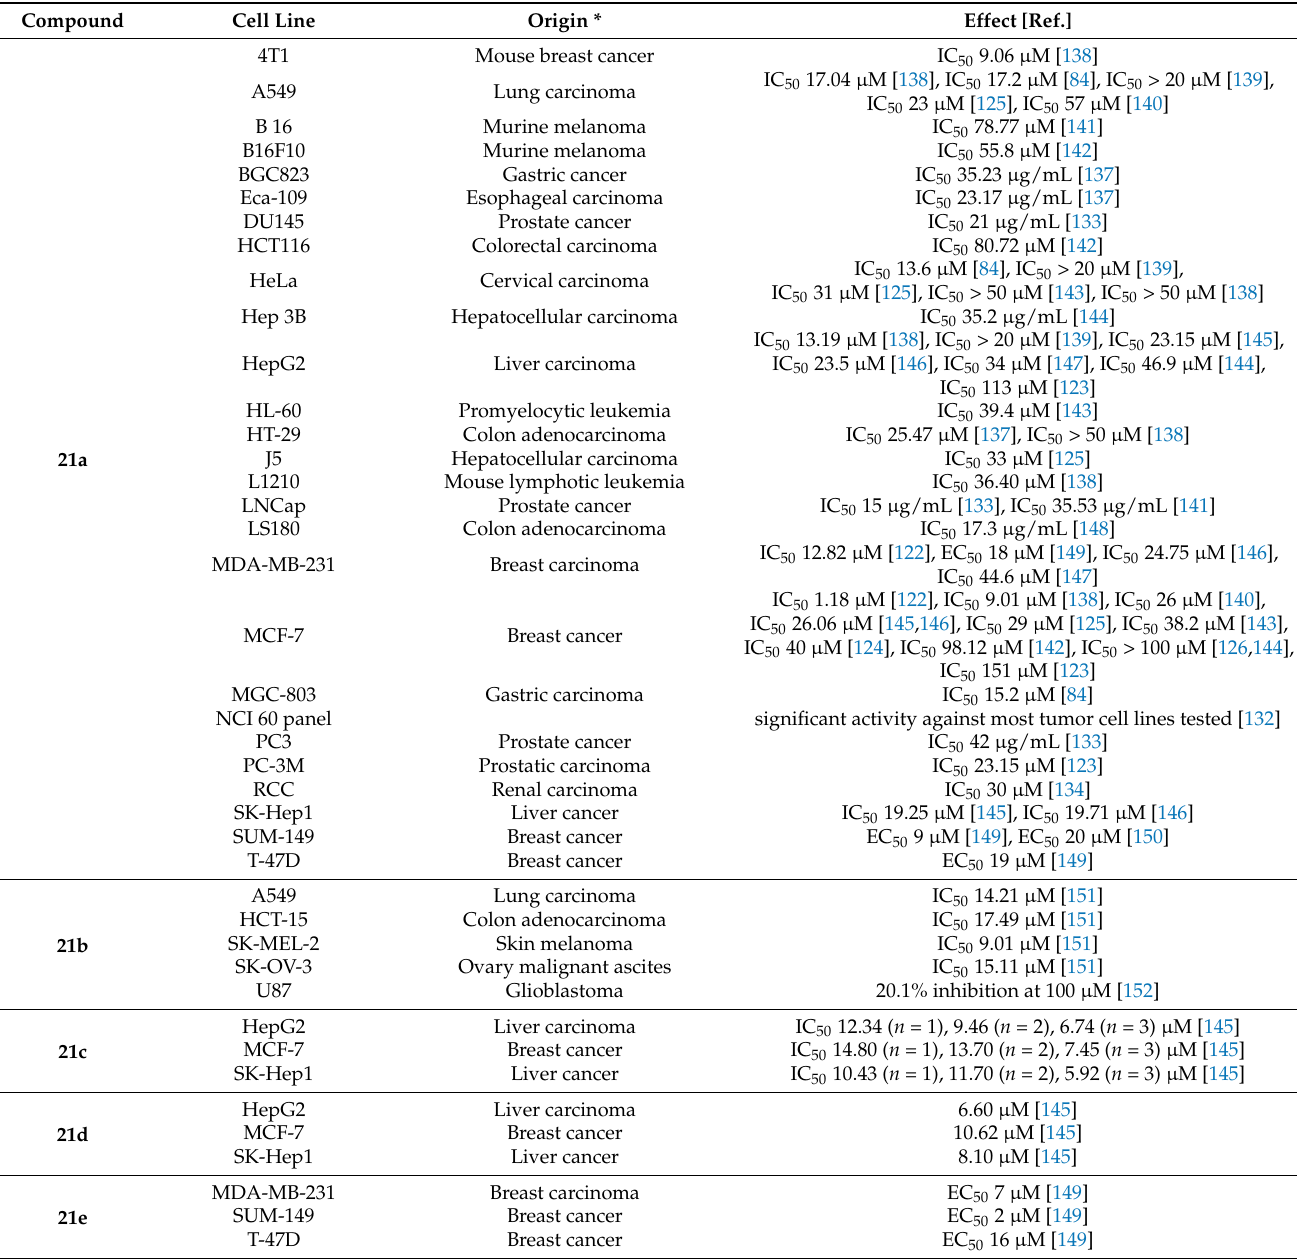
Table 1. Cytotoxicity of fungal endoperoxides on different cell